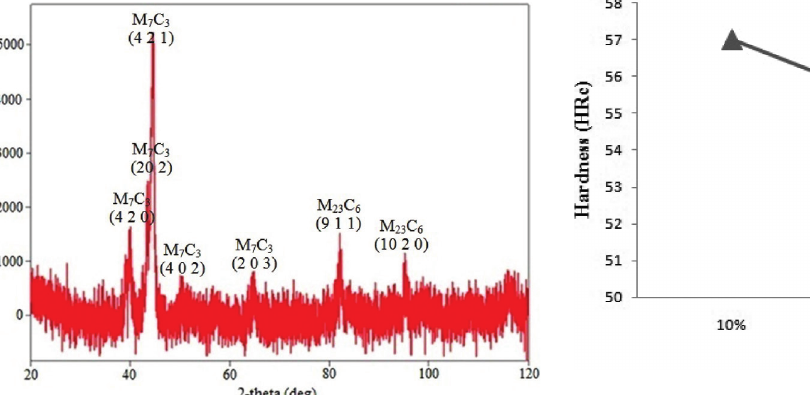
Fig. 5: Hardness of (10% Cr–12% Cr–14% Cr contained)